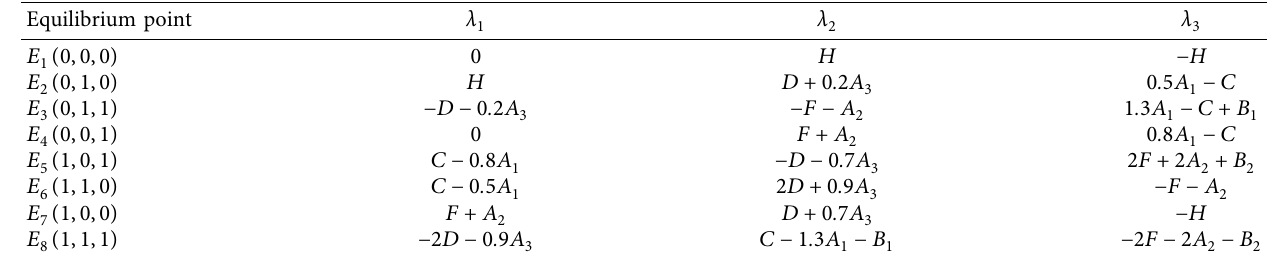
Table 3: Eigenvalues of the Jacobian matrices.